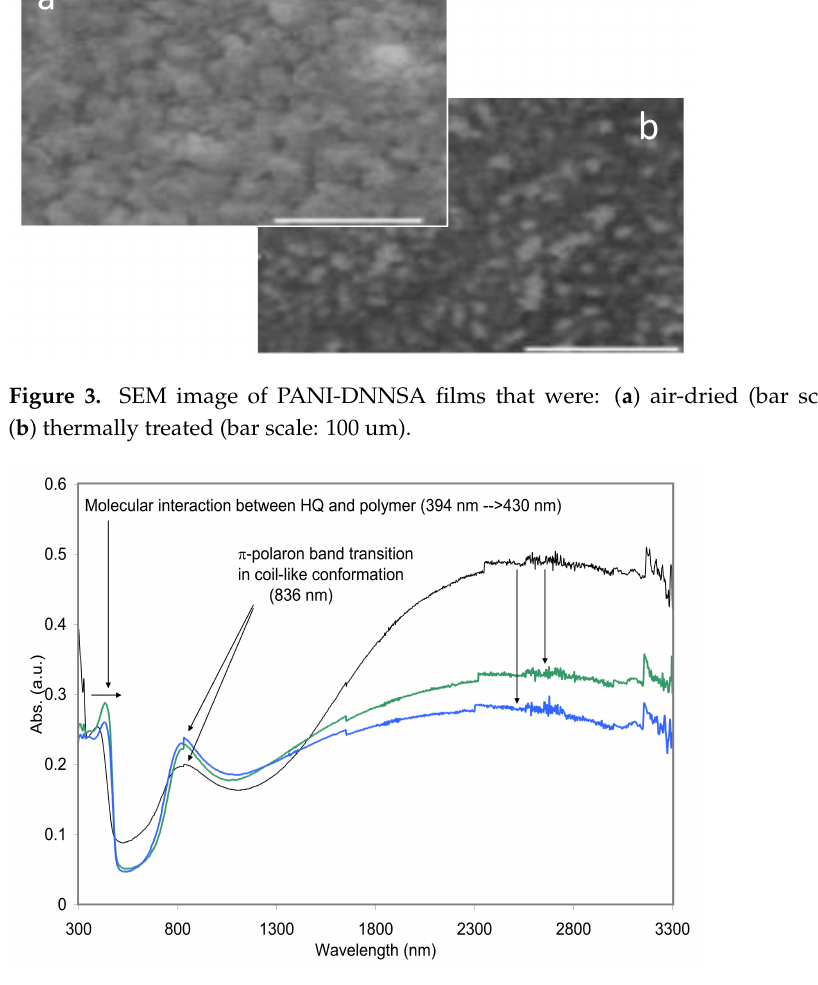
Figure 4. UV–Vis–NIR spectra of PANI-DNNSA films (black) that were film doped with HQ (green and blue). The sample with blue was dipped in BCS for 30 s